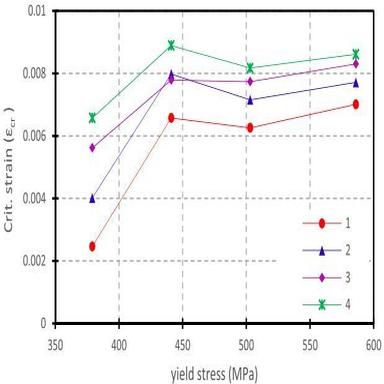
Plot of εcr vs. YS for DT1 pipe (fp = 0.6).